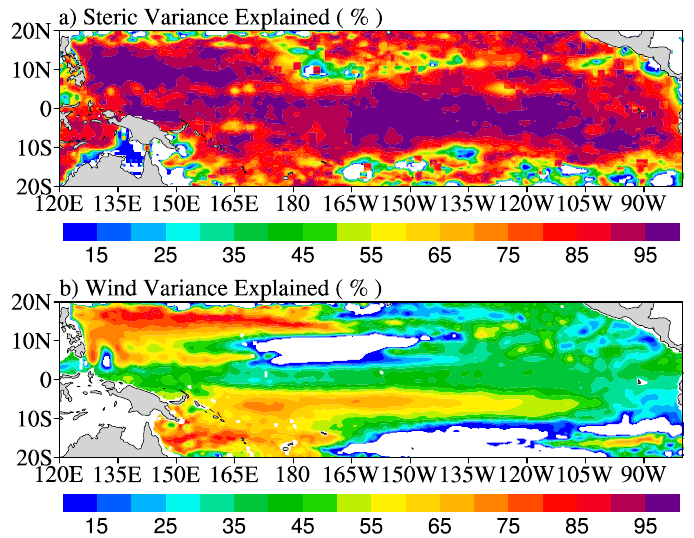
Figure 9. The decadal sea level explained variances of ( a ) the steric effect and ( b ) the dynamic pro- cess.